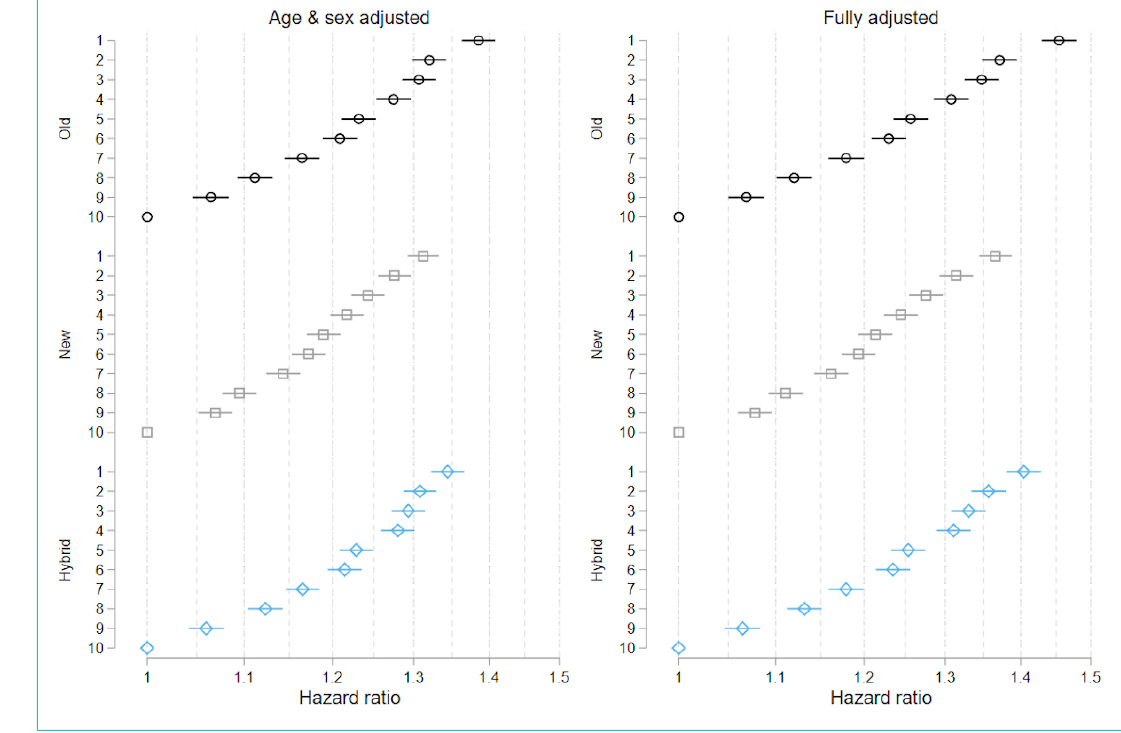
Figure 3: Hazard ratios of all-cause mortality across deciles of the three versions of the Swiss-SEP indices. Analyses based on Swiss Nation- al Cohort data on 304,000 deaths between 2012 and 2018 among 5.25 million individuals aged 30 or older. Fully adjusted analyses included age, sex, nationality, civil status, language region and level of urbanisation. Group 10 (highest SEP index) on the Y-axis is the reference group for all